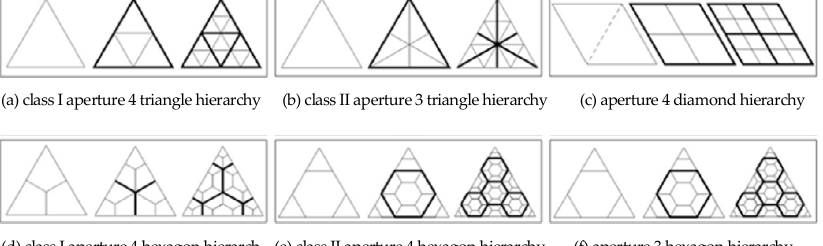
Figure 2. Recursive subdivision methods of different partition topologies [9].